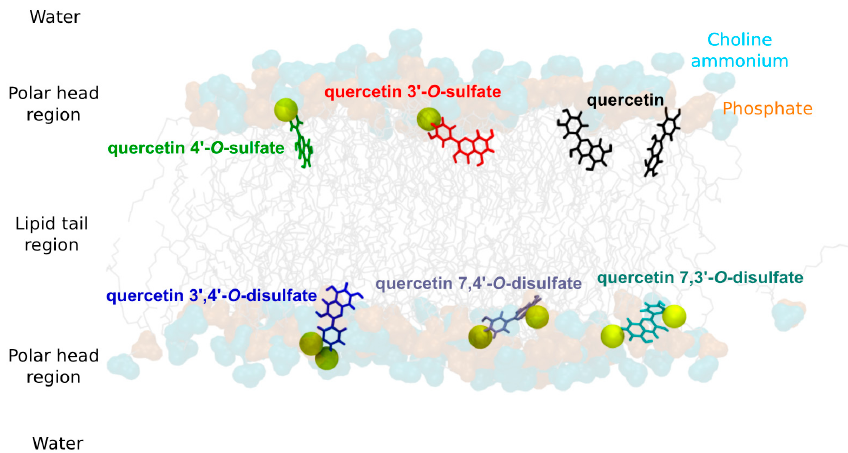
Figure 4. Representative snapshots of quercetin derivatives in 1-palmitoyl-2-oleoyl- sn -glycero-3- phosphocholine (POPC) membrane. Phosphate and choline ammonium moieties are depicted in orange and cyan, respectively. Sulfate moieties of each solute are pictured in yellow van der Waals